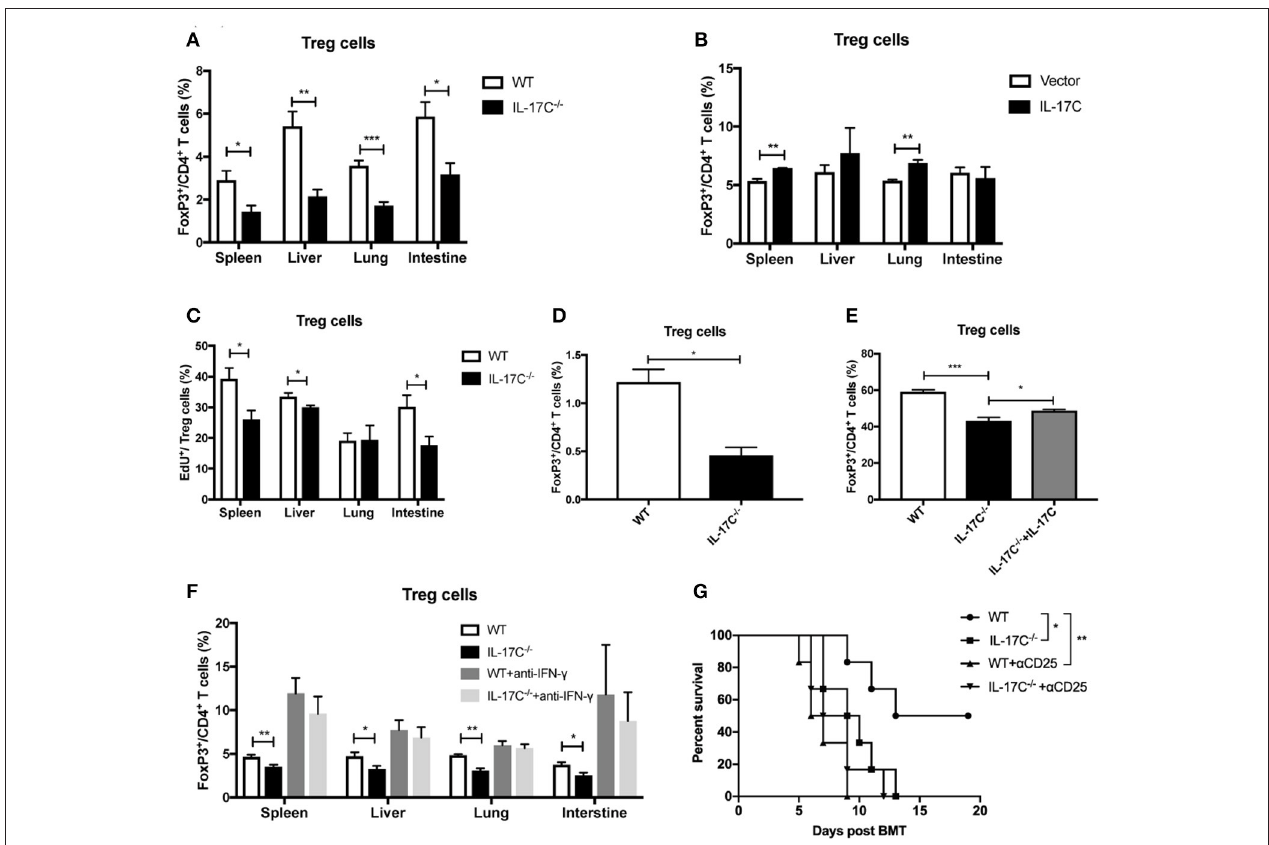
FIGURE 5 | IL-17C promotes Treg cells differentiation. Lethally irradiated BALB/c recipients were transplanted with 1 × 10 ∧ 7 bone marrow cells and 5 × 10 ∧ 6 splenocytes from B6 WT and IL-17C − / − donors, respectively. ( A ) Percentages of Treg cells in spleen, liver, lung, and intestine were detected on day 14 post-transplantation; n = 5–6 per group. ( B ) Percentages of Treg cells in BALB/c recipients IL-17C overexpression and vector control were detected on day 14 post-transplantation; n = 5–6 per group. ( C ) BALB/c recipients were transplanted with B6 WT and IL-17C − / − allografts respectively, and injected with 5 mg/kg